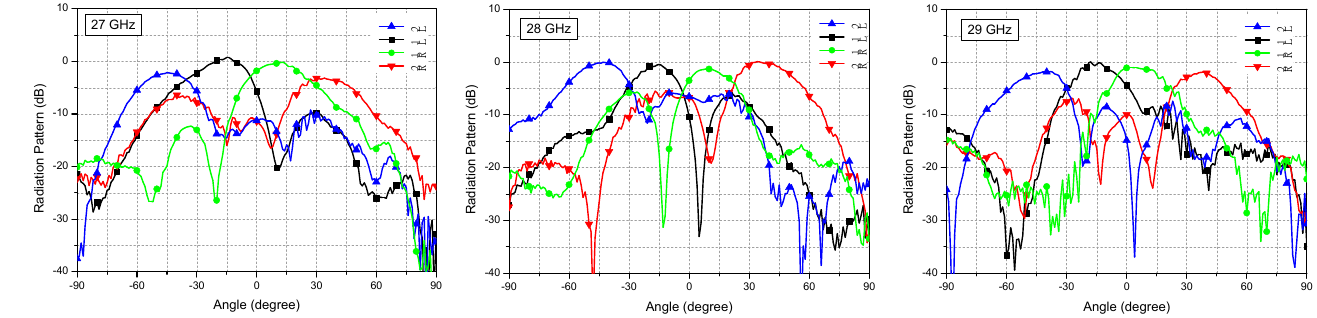
Figure 11. Measured radiation patterns in 27, 28, and 29 GHz. The antenna gains for the four switched beams over the 27–29 GHz band are drawn in Figure 12. The antenna gains for the four beams are found to be +5.8–+6.7 dBi at 28 GHz. Since all the design optimization efforts have been focused on the 28-GHz center frequency performance, the four-beam antenna gains at 28 GHz show the least variation. However, the variation becomes greater, that is +3.6–+6.7 dBi at 27 GHz and +4.8–+6.7 dBi at 29 GHz. It is also interesting to note that the two side-beams of 2L/2R exhibit steeper gain drop than the center-beams of Figure 12. Antenna gains versus the frequency for the four directional beams.